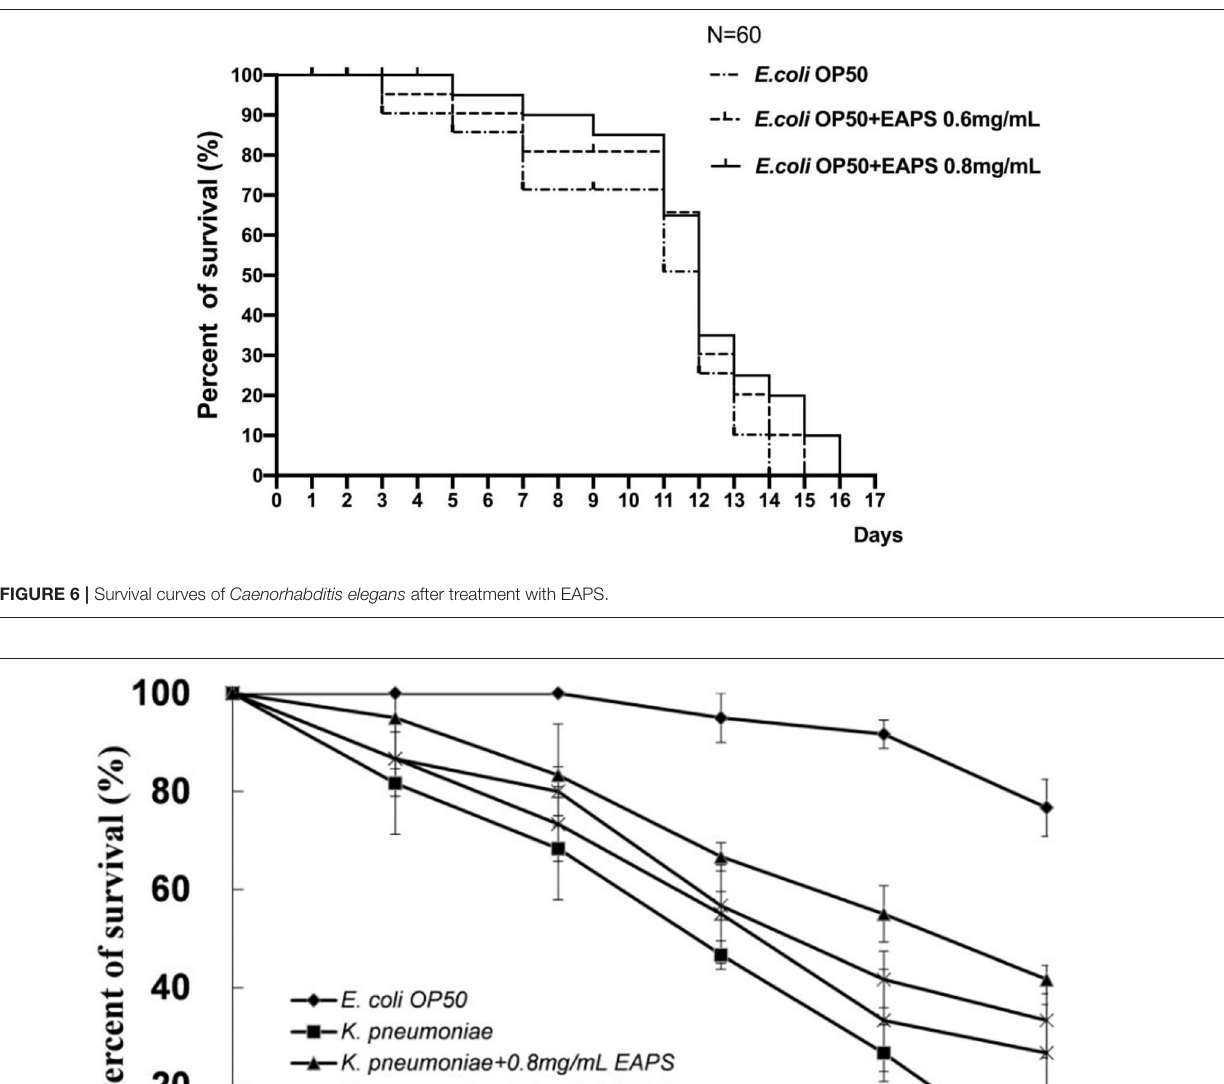
Relative Gene Expression in C.